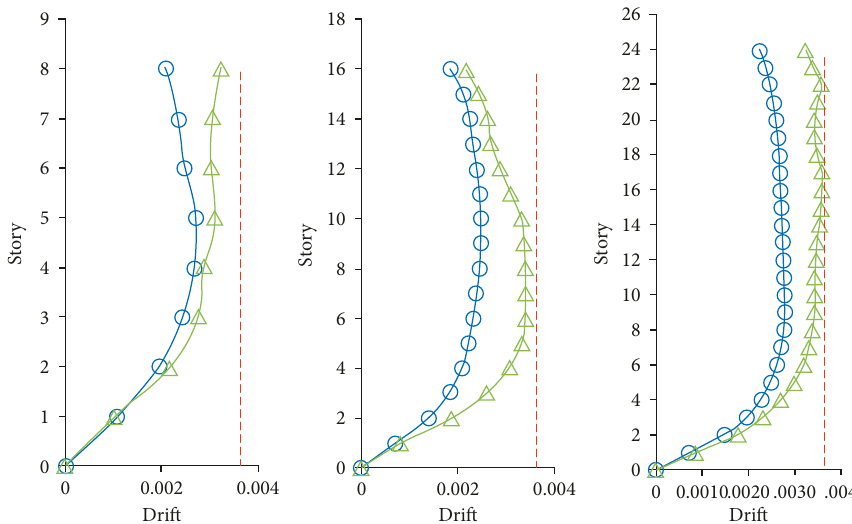
Figure 11: Comparing diagrams of the relative lateral displacement of 8-, 16-, and 24-story buildings.